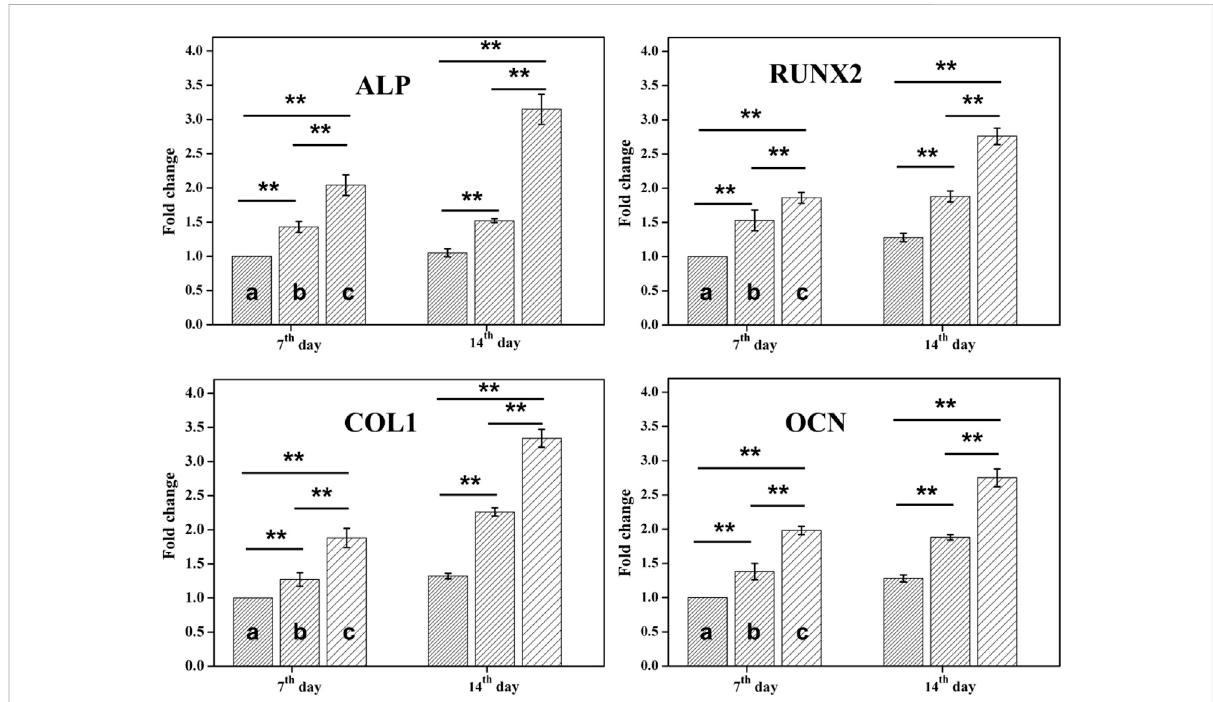
FIGURE 6 RT-PCR analysis. mRNA analysis of osteogenic markers of ALP, Runx2, COL1 and OCN by RT-PCR tests on day 7 and 14 ( n = 3, * p < 0.05, ** p < 0.01). Statistically signi fi cant differences in comparison with (A) control (untreated cells), (B) tetra-PEG hydrogel and (C) ALN-conjoined tetra-PEG